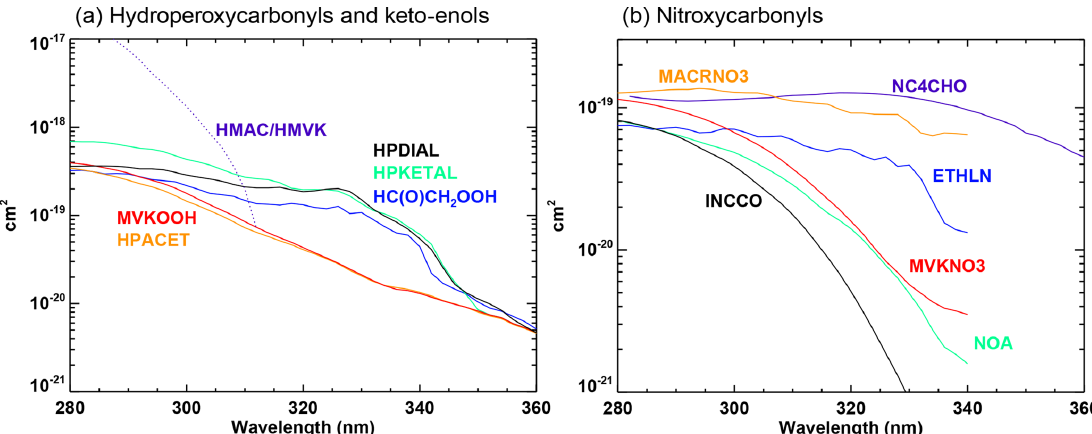
Figure 3. Absorption cross sections (in cm 2 molec. − 1 ) of (a) hydroperoxycarbonyls and keto-enols (HMAC and HMVK) and (b) nitroxy- carbonyls. Species notation as in Table 1.